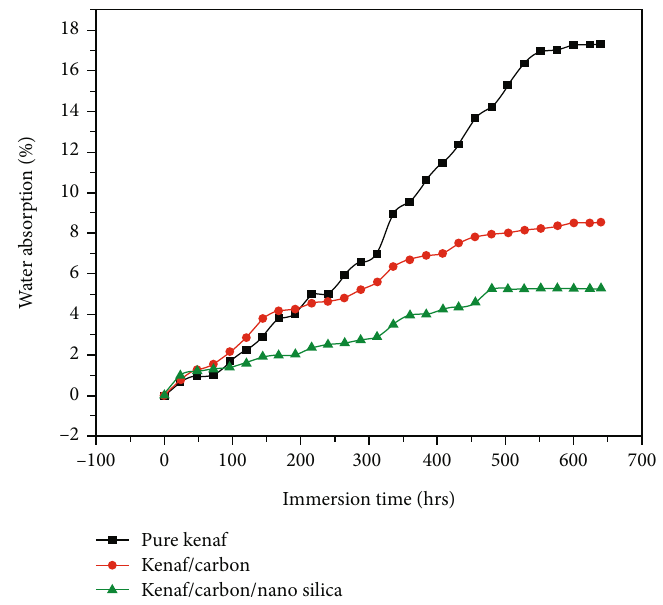
Figure 9: Water retention behaviour of kenaf/carbon/nanosilica/epoxy-based hybrid